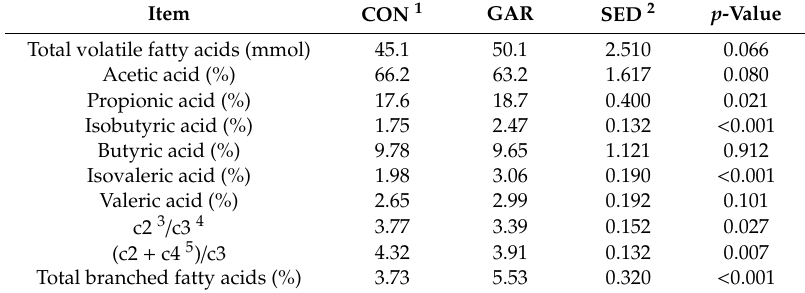
Table 6. Total volatile fatty acids and molar percentage of volatile fatty acids in the feces of finishing pigs.